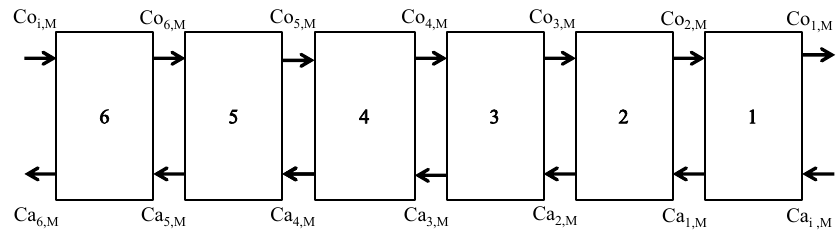
Figure 3. Continuous-countercurrent-extraction process.